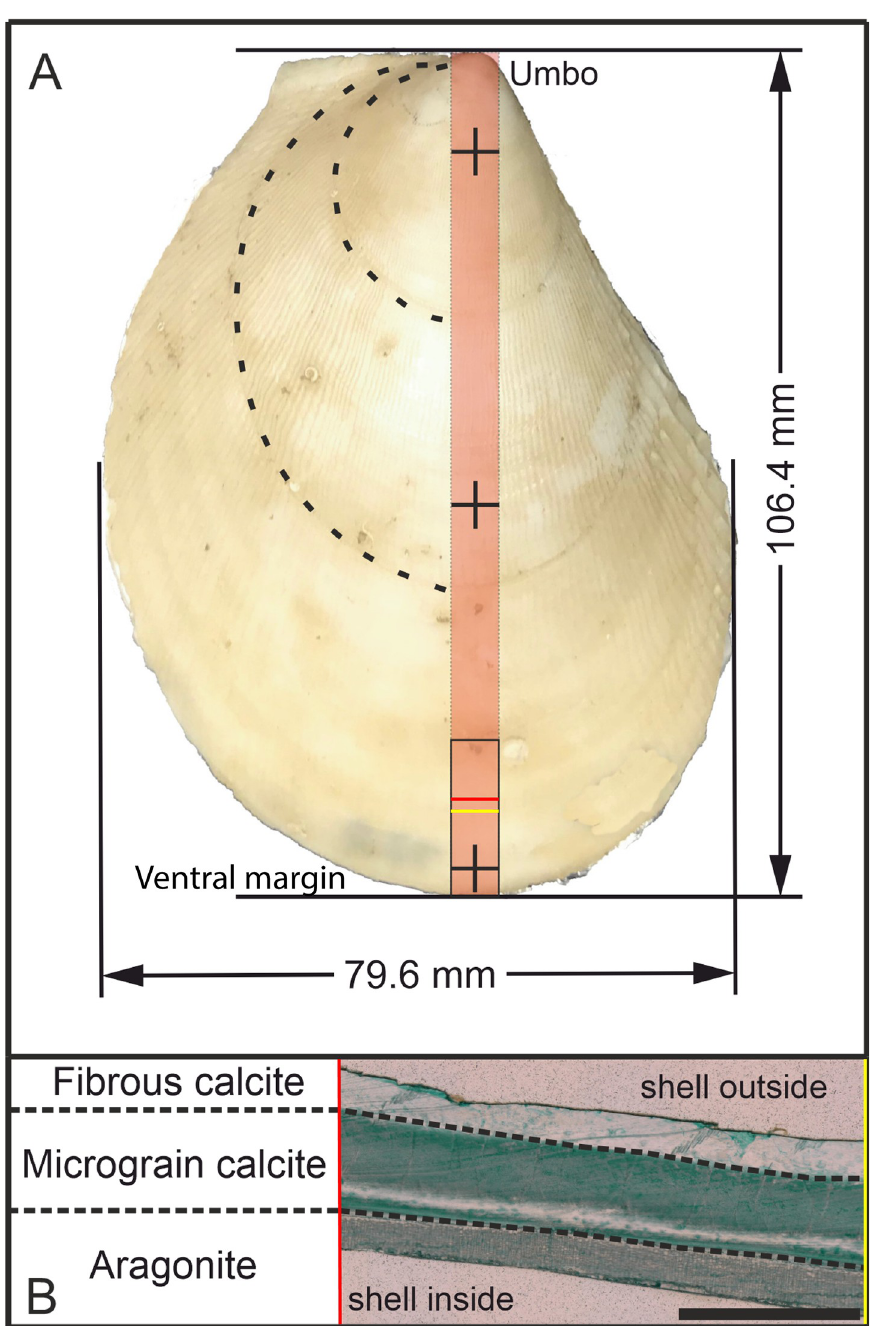
Fig 2. Sample overview and crystalline phases in the shell of A . excavata . A: Sample 17R from the Sula Reef. The red area marks the cut slab and the black rectangle shows the investigated area. Crosses mark the position of shell thickness measurements (15 mm from umbo, 50 mm from umbo and 5 mm from ventral margin). The shell length was measured perpendicular to the bivalve auricle and the width was measured parallel to the auricle of the bivalve along the maximum distance. Dashed lines show visible growth lines B: Cross-section of the shell (location marked in A with red and yellow lines), colored with Mutvei’s solution [49]. Scalebar is 1 mm.